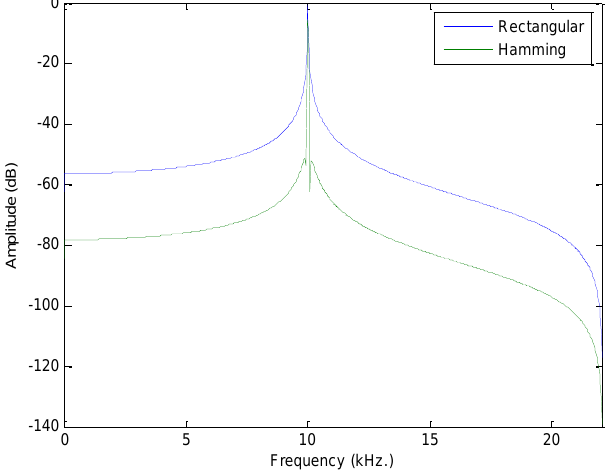
Figure 6. Effect of framing in the spectrum of a 10 kHz pure tone. Rectangular and Hamming window functions.